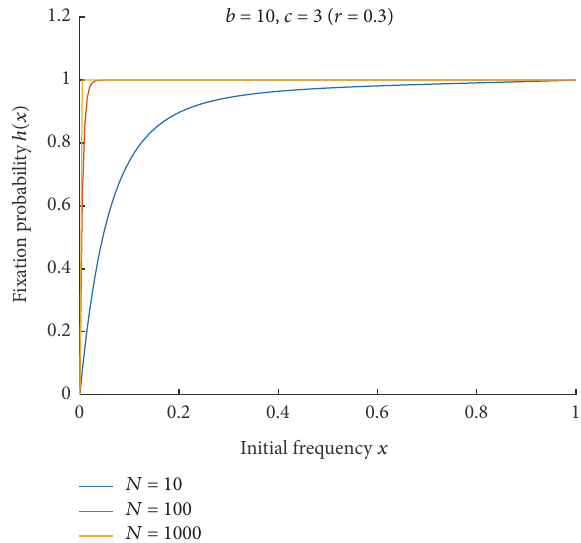
Figure 2: The plot of ℎ(𝑥) . When 𝑟 = 0.3 , which is below 𝑟 ∗ , the probability that cooperators will fix gets very large, regardless of the starting frequency of cooperators, as group size